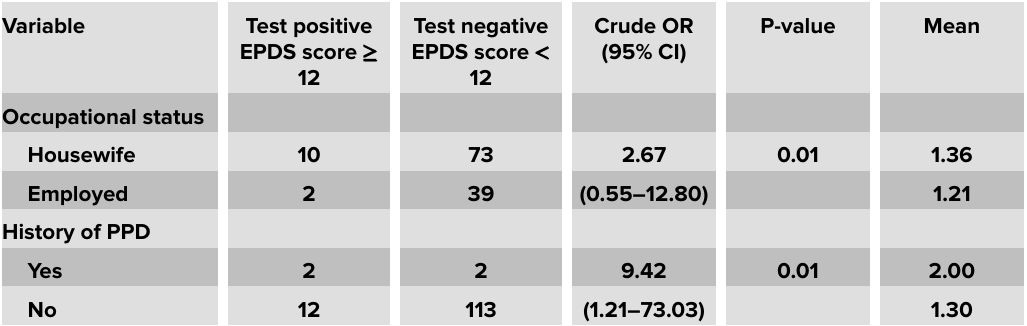
TABLE 2: Results of the Chi-square test on factors associated with EPDS scores; n = 129.